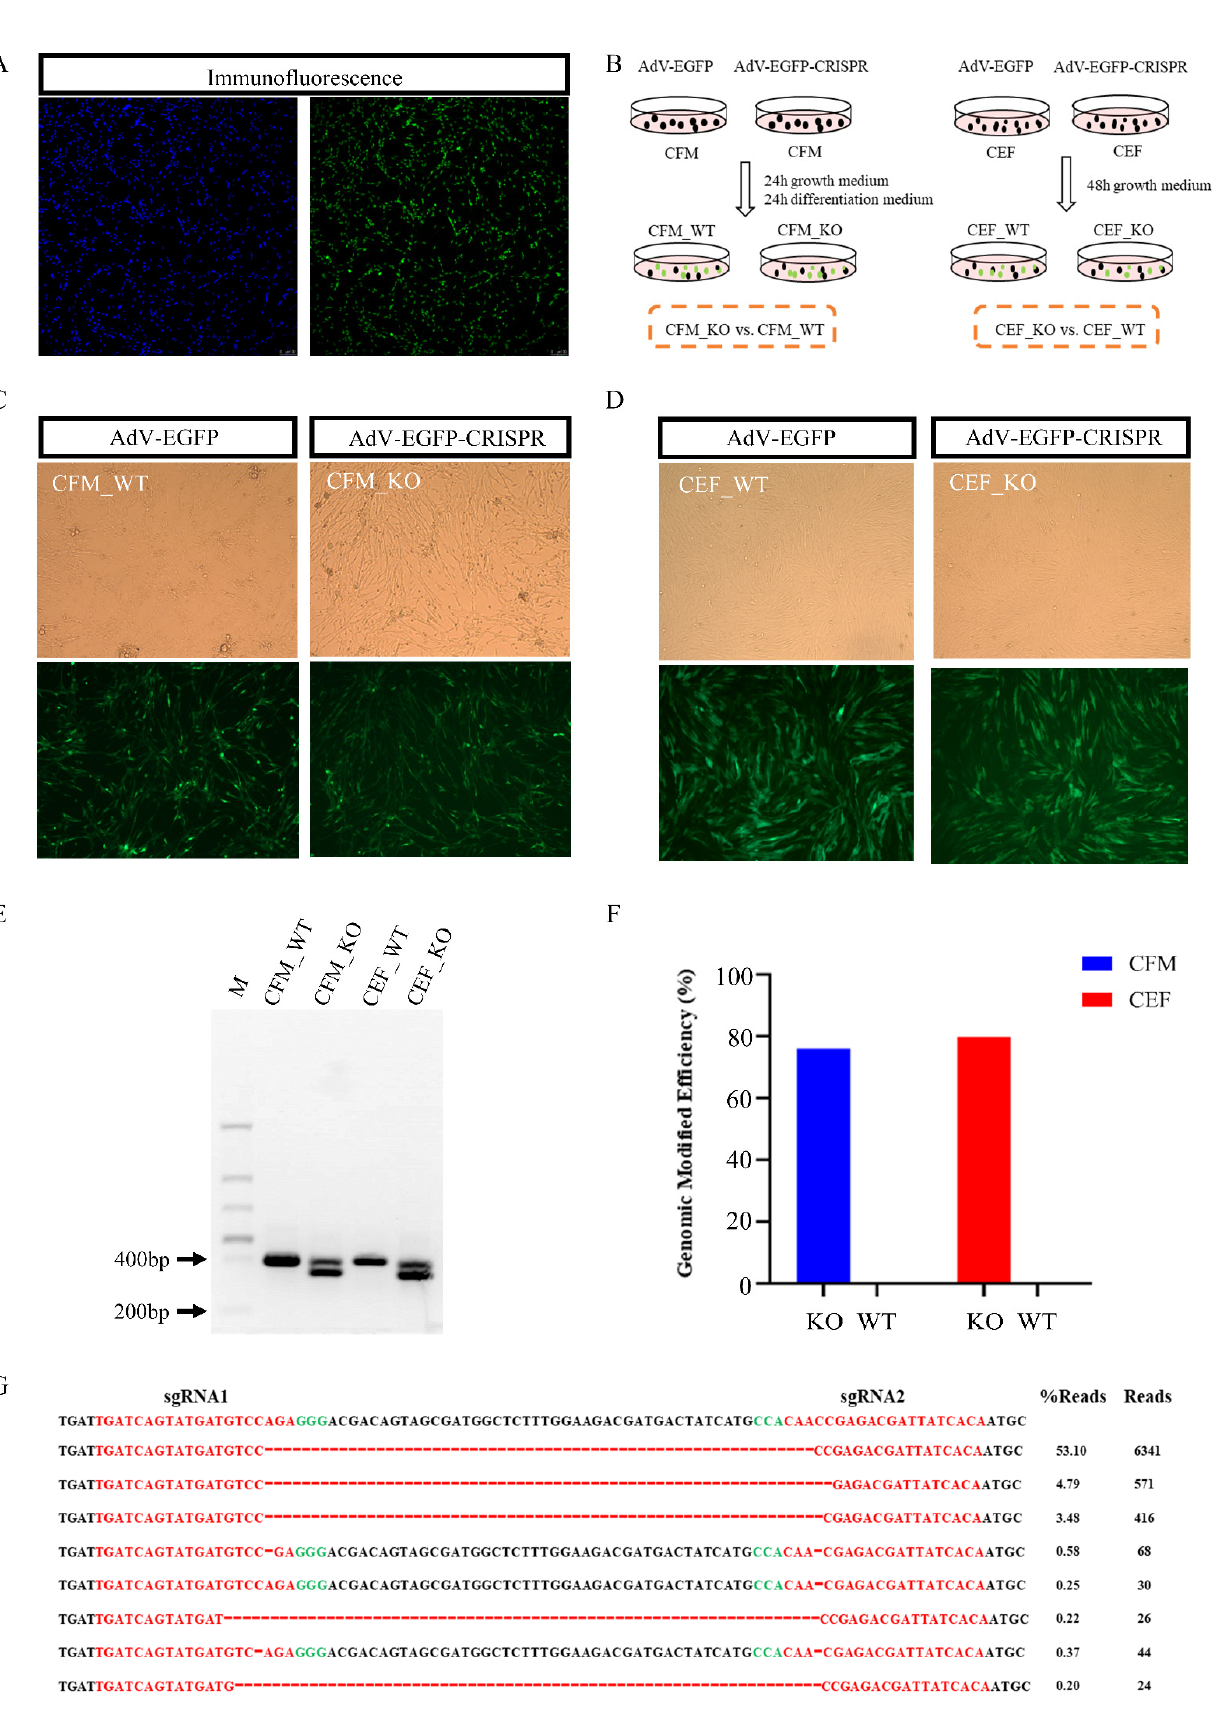
Figure 1. Preparation and validation of MSTN knockout (KO) cells. ( A ) Chicken fetal myoblasts (CFMs) were fixed, nuclei were stained with DAPI, and the cells were immunostained for